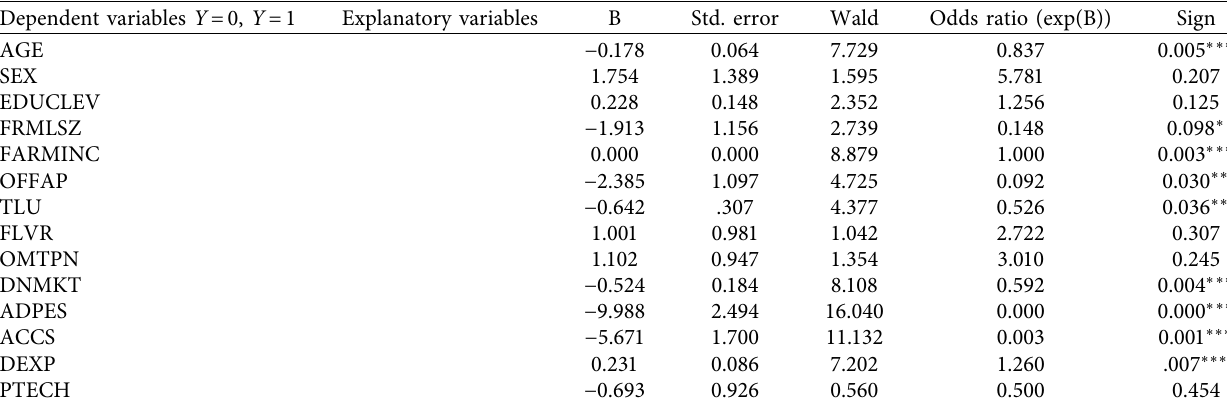
Table 8: Parameters estimation of binary logistic regression on the adoption status of dairy households in